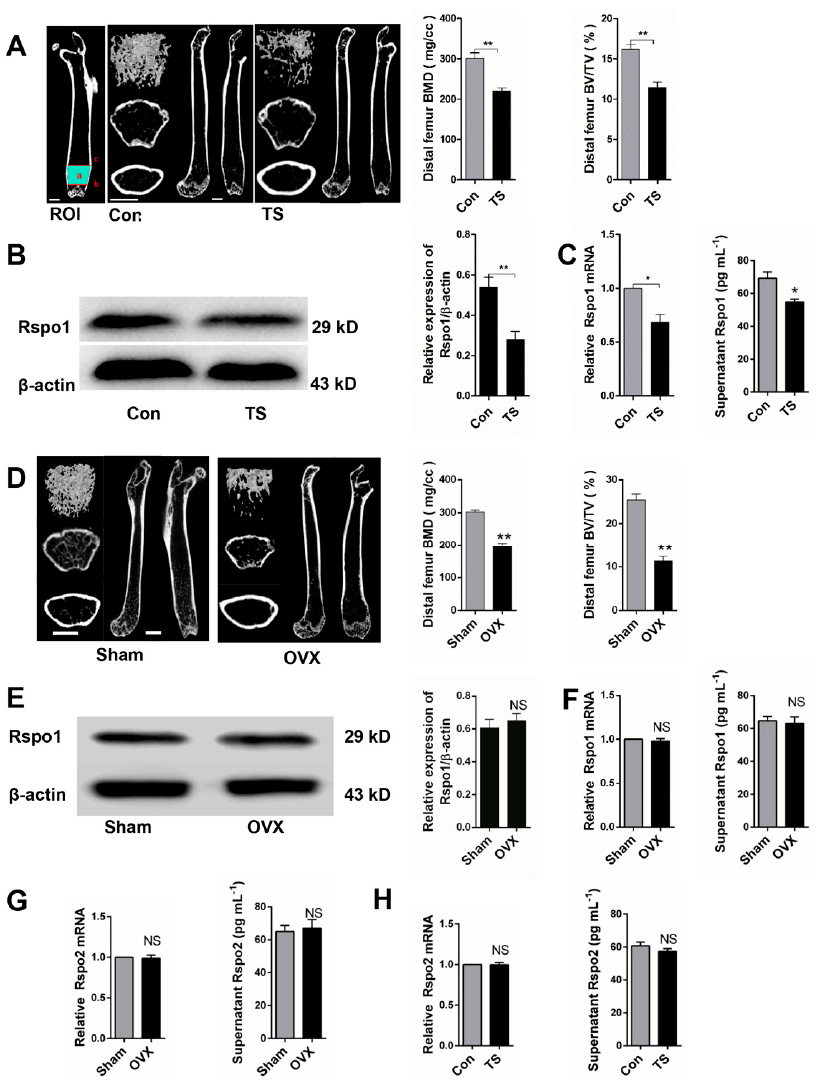
Figure 2. Mechanical unloading resulted in decreased expression of Rspo1 in BMSCs in vivo. ( A ) Representative μ CT images and quantification analysis of bone parameters of distal femurs in Con and tail suspension (TS) mice. n = 6. Scale bars, 1 mm; ( B ) Western blot analysis and ( C ) mRNA expression and supernatant content analysis of Rspo1 in the BMSCs from TS and Con group mice bones; ( D ) representative μ CT images and quantification analysis of bone parameters of distal femurs in sham and OVX mice. n = 6. Scale bars, 1 mm; ( E ) Western blot analysis and ( F ) mRNA expression analysis and supernatant content of Rspo1 in the BMSCs from OVX and sham group mice bones; ( G , H ) mRNA expression and supernatant content analysis of Rspo2 in the BMSCs from the two group of mice bones. Data are presented as the mean ± SD, * p < 0.05, ** p < 0.01. All p -values are based on Student’s t -test. Con: control; TS: tail suspension; Sham: sham surgery; OVX: ovariectomized; μ CT: micro-computed tomography; ROI: region of interest.